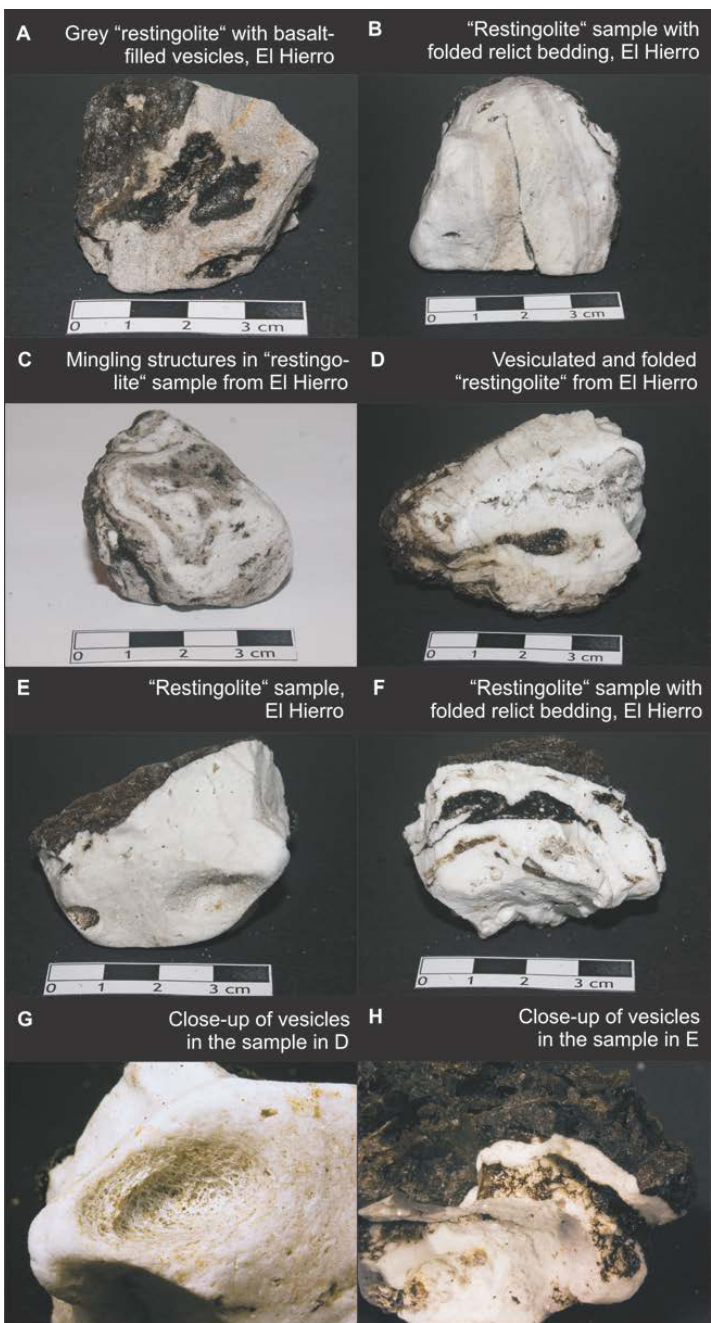
Fig. A1. Images of “restingolite” samples from El Hierro, displaying typical features, such as a rind of basanite, layering, folding, vesicular- ity, and mingling